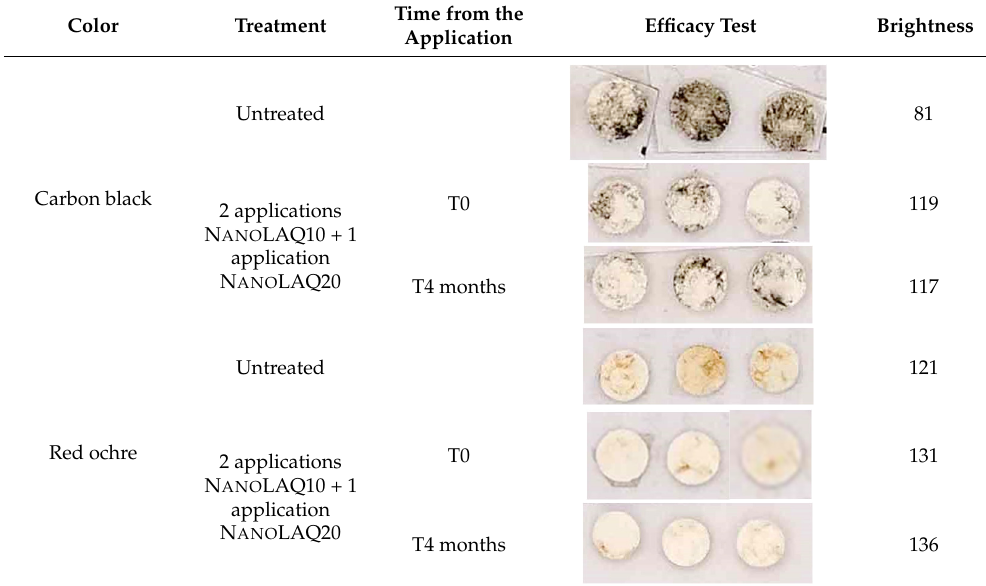
Table 6. Efficacy test on paintings in situ.